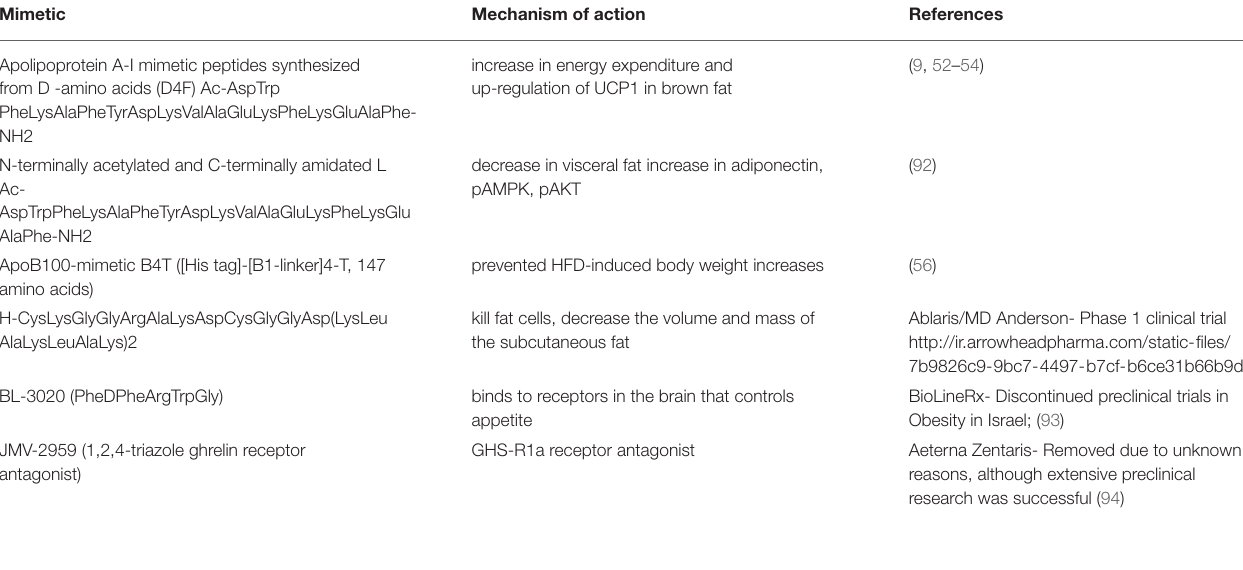
TABLE 2 | Peptidomimetics and synthetic peptides for antiobesity